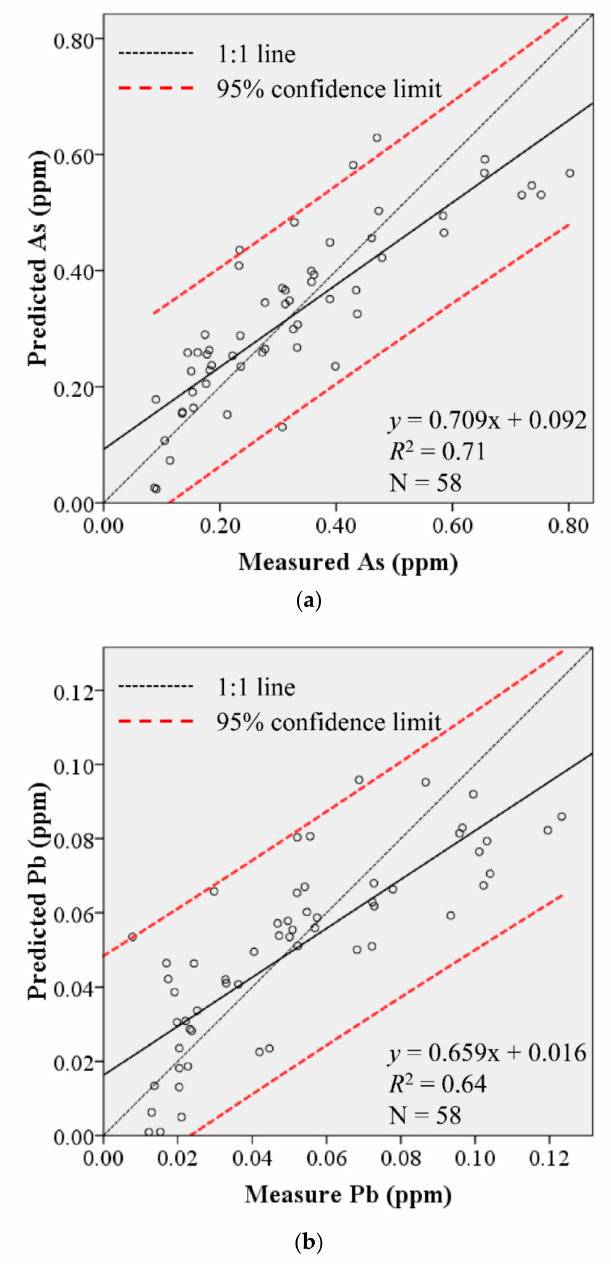
Figure 7. Evaluation models of ( a ) As and ( b ) Pb prediction models based on the comparison between measured and predicted concentrations using a test set. The slope (solid black line) close to 1:1 line indicates no bias between the predicted and measured